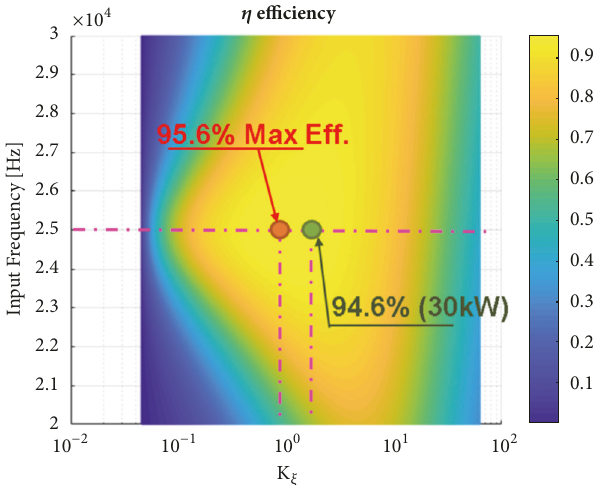
Figure 11: Efficiency of the proposed solution with respect to input frequency and k 𝜉 .